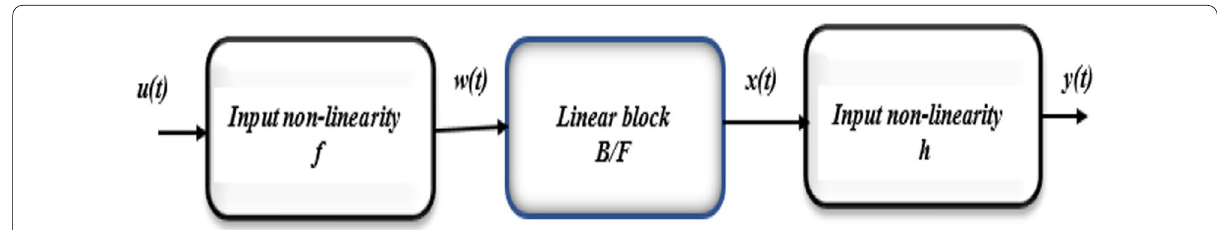
Fig. 1 Schematic of Hammerstein-Wiener model. w ( t ) = f ( u ( t )) is the nonlinear function that converts input data, x ( t ) = w ( t ) B / F is a linear transfer function, f and h are acting on the input and output port of the linear block, respectively. The other functions, w(t) and x(t) are used to define the output and input of the linear